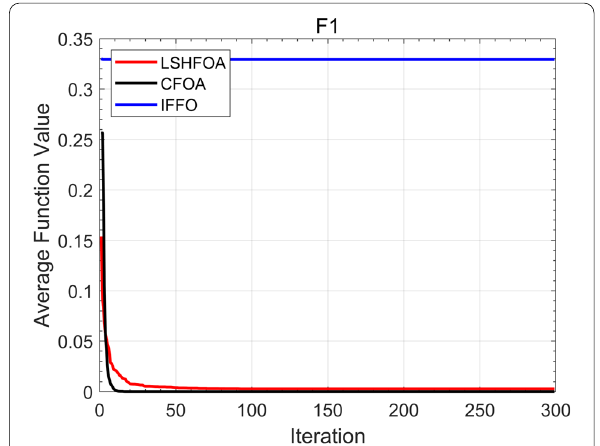
Fig. 7 Performance of the algorithm under F1